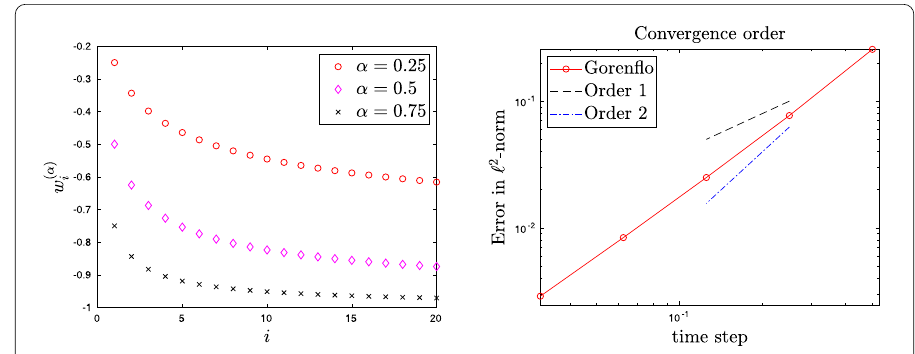
Figure 1 Numerical experiment 1. (Left) Coefficients { w ( α ) i } 1 ≤ i ≤ 20 for α = 0.25,0.5,0.75. (Right) Convergence graph for Gorenflo’s